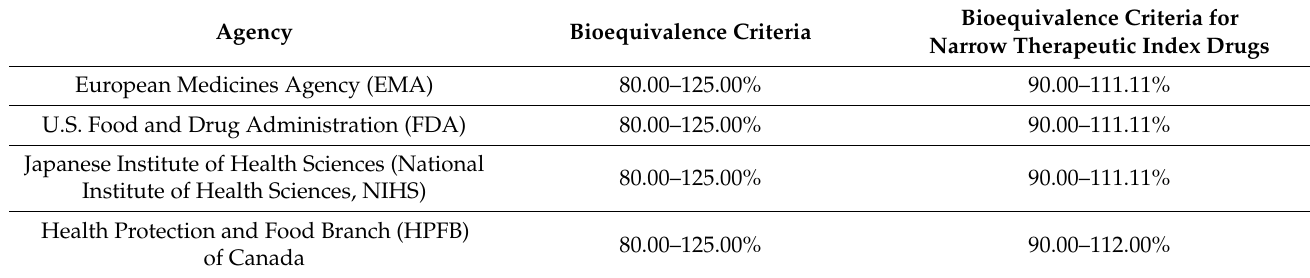
Table 1. Criteria for regulatory approval of